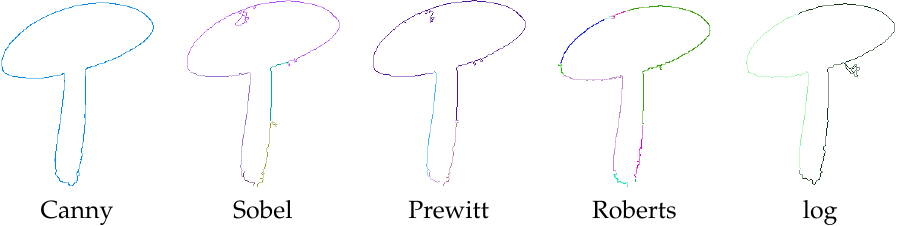
Figure 2. Different edge detection methods applied to an image presented in Section 4. Different colors identify different 8-connected components.